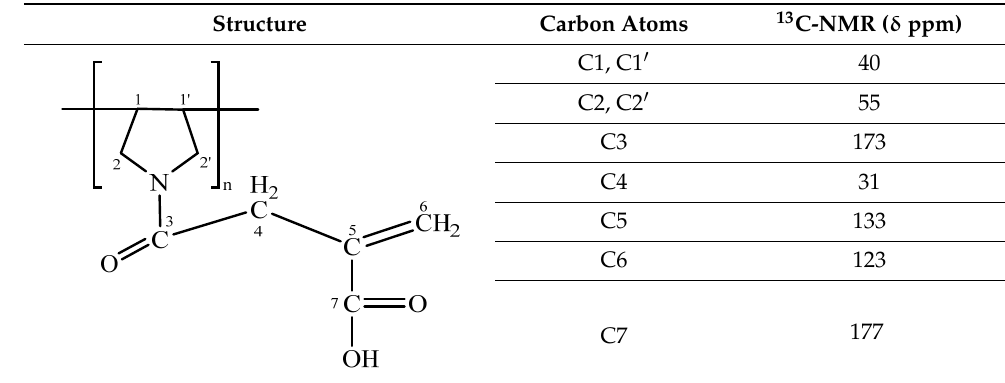
Figure 1. 13 C-NMR spectrum of (DAA:IA) copolymer (sample 2). The results revealed that the DAA cyclo-polymerized to form pyrrolidine rings [25], while the IA formed a condensation product with the pyrrolidine -NH group. Moreover, the presence of the ethylenic carbons accounted for the low composition of IA in the syn- thetized copolymers (Table 2). Table 2. 13 C-NMR spectral data of copolymerization of IA and DAA. Structure